Question: Which visualization type does this figure use?
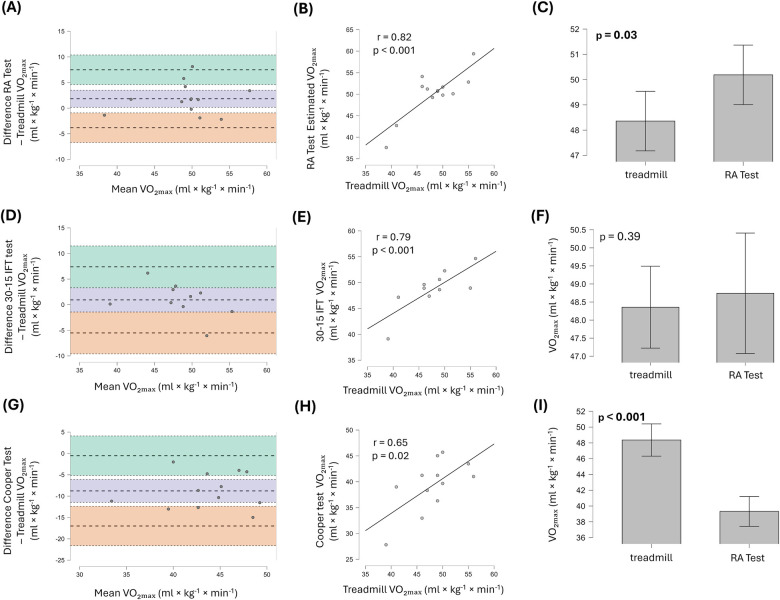
Answer: scatter